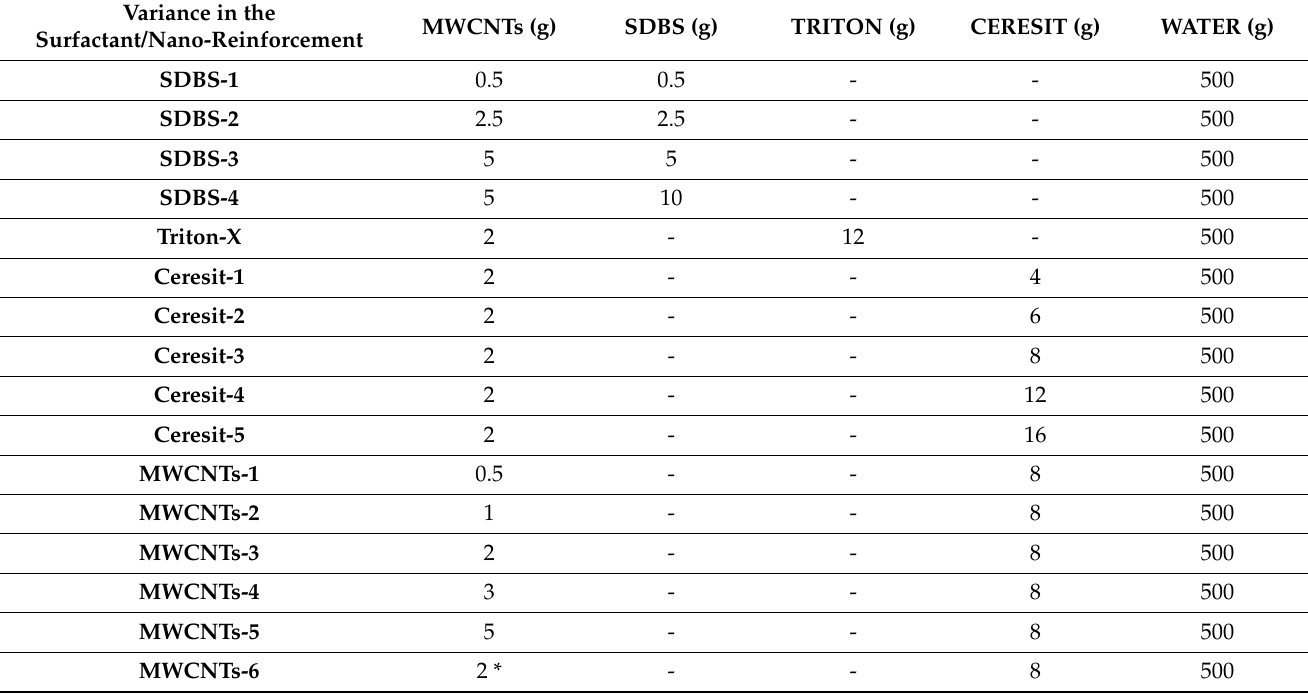
Table 3. Mixing quantities (g) of the materials used for the MWCN/aqueous dispersions. Variance in the